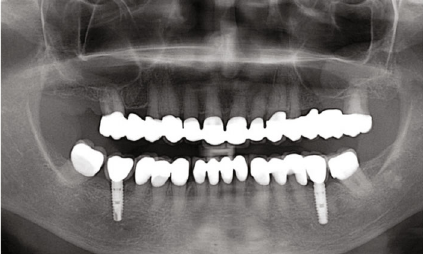
Figure 15: Panoramic radiograph taken two years after the procedure showing that the dental pulp was not involved after the prosthetic